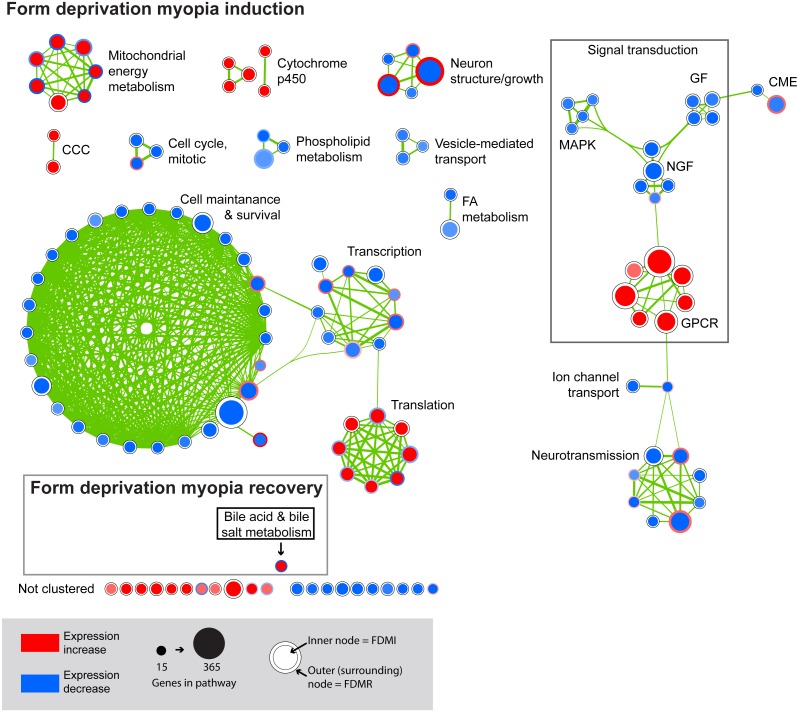
Enrichment map for highly clustered pathways in form deprivation induction and recovery.Axial elongation during 10 days of form-deprivation compared to normal unoccluded controls resulted in 130 altered pathways in retina/RPE choroid (inner node) while 24 h recovery (outer annulus) identified only one statistically significant pathway i.e., bile acid & bile salt metabolism. Pathways not statistically enriched during FDMR are shown for comparison purposes. Notably, expression profiles of FDMI and FDMR are consistent despite the fact that only the FDMR data includes choroidal tissue. Pathways highly expressed during induction (red inner node) were often suppressed during normal vision and recovery (blue outer annulus) and vice versa. Note: Each node represents a biological pathway from File S1. The colour of each node emphasises the direction of expression and normalised enrichment score (NES). Node size is relative to the number of genes in the pathway. Thickness of the connections (green) between each node reflects the degree of similarity between each gene set. There were 22 unclustered pathways in FDMI that did not meet the clustering similarity coefficient of 0.5. Note cluster names: CCC, complement and coagulation cascades; CME, clatherin-mediated endocytosis; FA, Fatty acid; GF, growth factors; GPCR, g-protein coupled receptors; MAPK, mitogen-activated protein kinases; NGF, nerve growth factor.